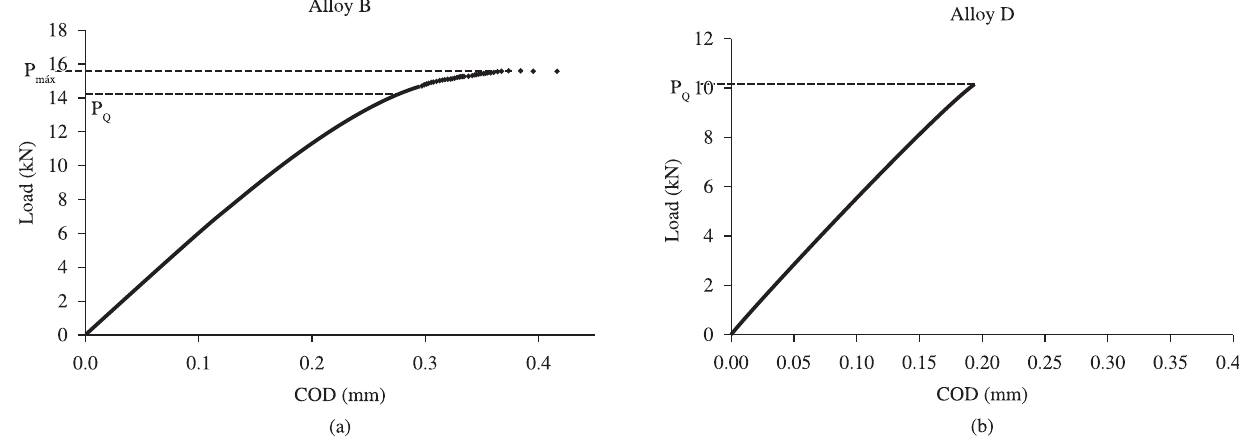
Figure 13. Load versus crack opening displacement form SEN(B) specimens for determination of KQ: a) steel B (0.017 wt. (%) of P) austenitized at 850 °C and tempered at 530 °C and b) steel D (0.031 wt. (%) of P) austenitized at 1000 °C and tempered at 470 °C.